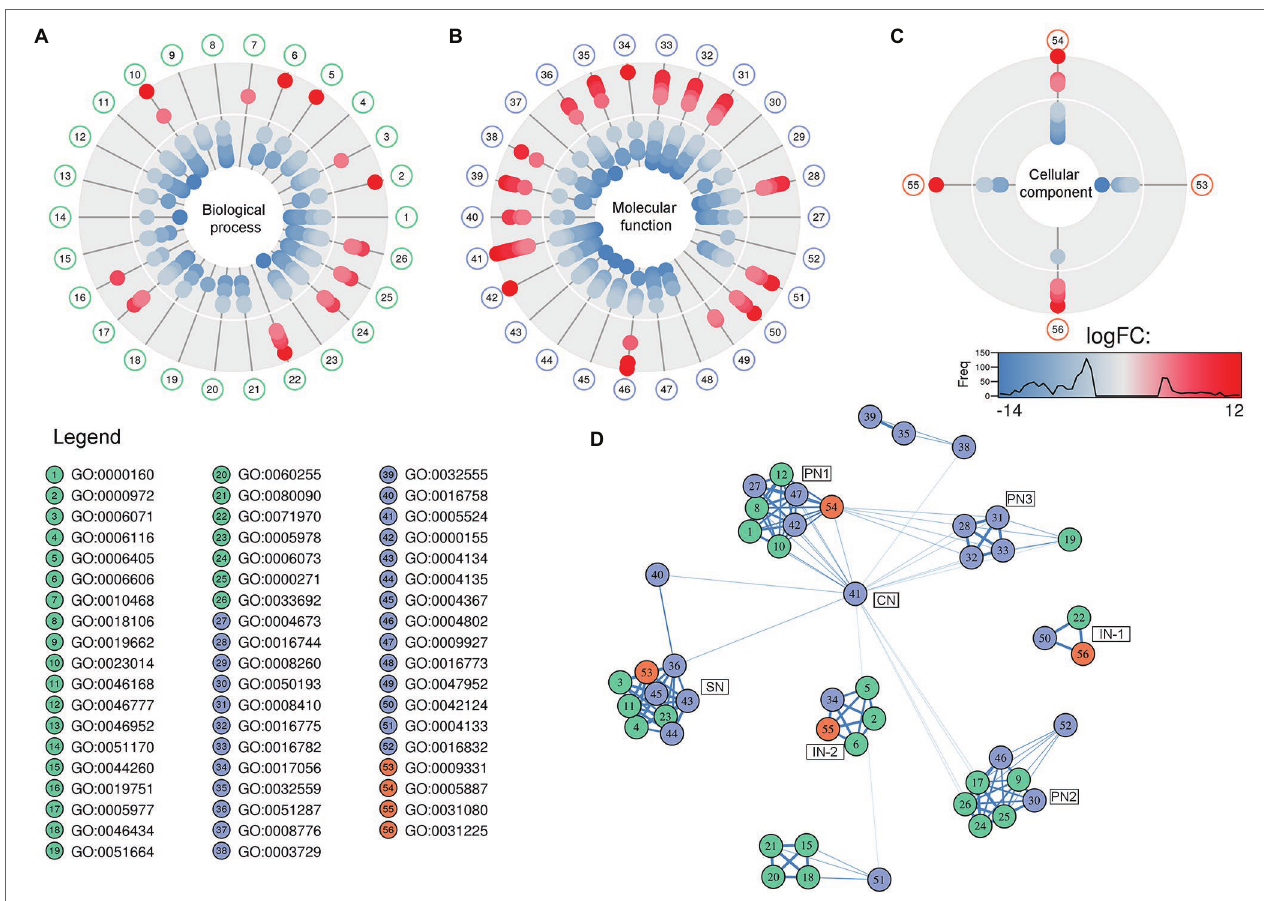
FIGURE 1 | Pie-donuts chart (A–C) showing the gene ontology (GO) term enrichment from the overrepresented functional annotations in the set of differentially expressed transcripts of Aspergillus sydowii exposed to extreme water deprivation by salt (5.13 M NaCl) compared to optimal salt concentration for growth (1 M NaCl). GOs are named using numbers from 1 to 56. (A) Biological process (green circles, 1–26). (B) Molecular function (blue circles, 27–52). (C) Cellular component (red circles, 53–56). White circle inside each donut represents logFC = 0. The transcripts associated with each GO are represented based on their logFC value as: upregulated transcripts (logFC > 1.5) are red filled circles inside the donuts; downregulated transcripts (logFC < − 1.5) are blue filled circles inside the donuts. (D) Multi-scale network obtained from the GO enrichment data. One central node (CN), three principal nodes (PN1, PN2, and PN3), one secondary node (SN), and two isolated nodes (IN) are observed. Only the GO sharing more than three transcripts between them are represented in the GO term-based network. GO legend: Biological process: 1-GO:0000160 phosphorelay signal transduction system; 2-GO:0000972 transcription-dependent tethering of RNA polymerase II gene DNA at nuclear periphery; 3-GO:0006071 glycerol metabolic process; 4-GO:0006116 NADH oxidation; 5-GO:0006405 RNA export from nucleus; 6-GO:0006606 protein import into nucleus; 7-GO:0010468 regulation of gene expression; 8-GO:0018106 peptidyl-histidine phosphorylation; 9-GO:0019662 non-glycolytic fermentation; 10- GO:0023014 signal transduction by protein phosphorylation; 11-GO:0046168 glycerol-3-phosphate catabolic process; 12-GO:0046777 protein autophosphorylation; 13-GO:0046952 ketone body catabolic process; 14-GO:0051170 import into nucleus; 15-GO:0044260 cellular macromolecule metabolic process; 16-GO:0019751 polyol metabolic process; 17-GO:0005977 glycogen metabolic process; 18-GO:0046434 organophosphate catabolic process; 19-GO:0051664 nuclear pore localization; 20-GO:0060255 regulation of macromolecule metabolic process; 21-GO:0080090 regulation of primary metabolic process; 22-GO:0071970 fungal-type cell wall (1,3)- β -D-glucan biosynthetic process; 23-GO:0005978 glycogen biosynthetic process; 24-GO:0006073 cellular glucan metabolic process; 25-GO:0000271 polysaccharide biosynthetic process; 26-GO:0033692 cellular polysaccharide biosynthetic process. Molecular function: 27-GO:0004673 protein histidine kinase activity; 28-GO:0016744 transferase activity, transferring aldehyde or ketonic groups; 29-GO:0008260 3-oxoacid CoA-transferase activity; 30-GO:0050193 phosphoketolase activity;